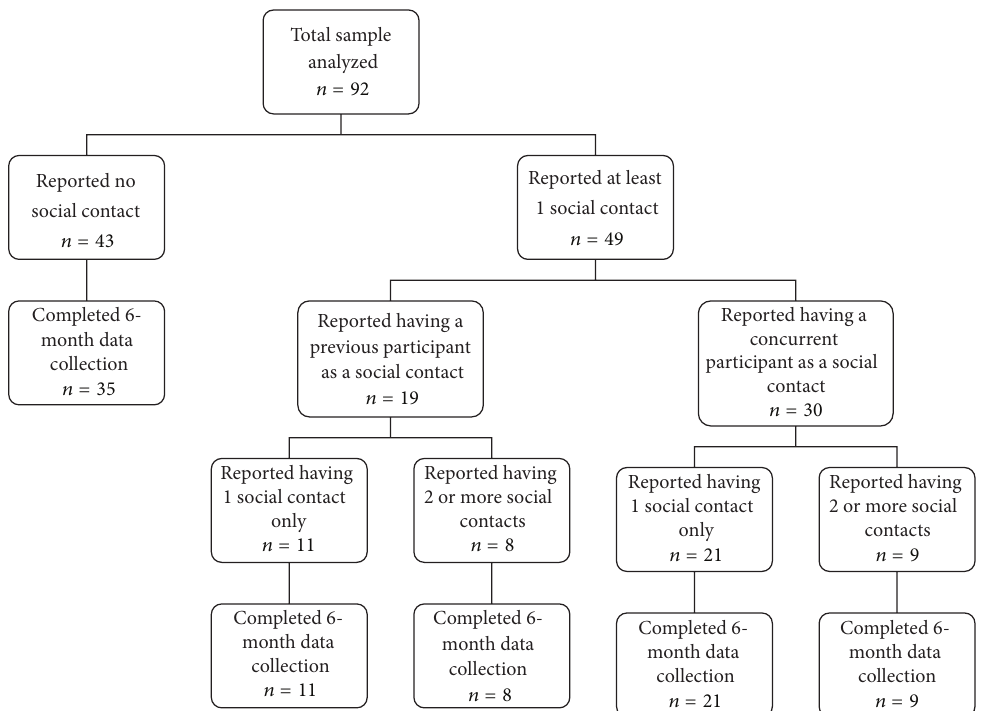
Figure 1: Flow diagram of index participants’ reporting of a social contact who is a previous or concurrent study participant.